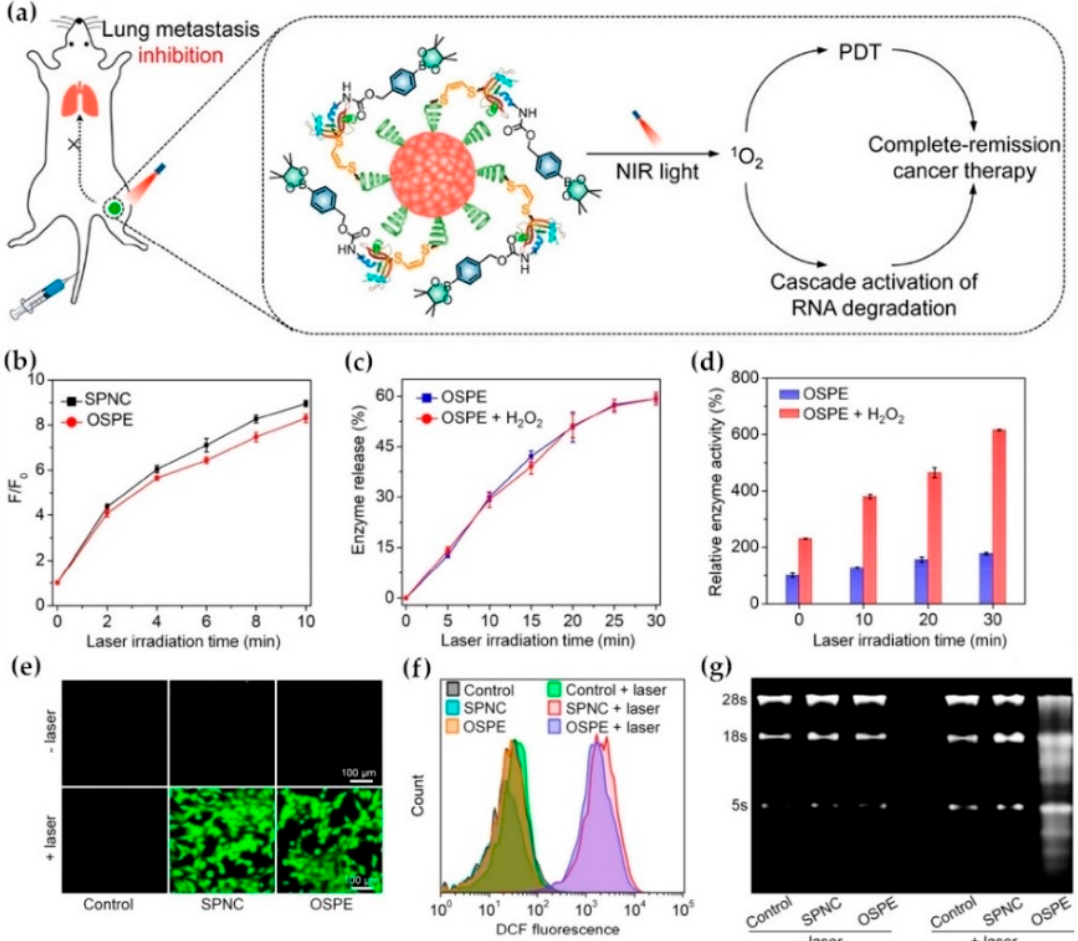
Figure 11. ( a ) Anticancer mechanism of NIR / 1 O 2 dual stimuli-responsive organic semiconductor pro-nanoenzyme (OSPE). ( b ) Under NIR irradiation, 1 O 2 was generated by SPNC (control nanoparticles without enzyme modification) or OSPE. ( c ) The correlation of the amount of enzyme released from OSPE with the time of NIR irradiation. ( d ) In the absence and presence of H 2 O 2 , the relative enzyme activity of OSPE after NIR light irradiation for di ff erent times. ( e ) Confocal fluorescence images and ( f ) flow cytometry analysis of 4T1 cancer cells treated with SPNC or OSPE ([SPN] = 40 µ g / mL) with or without 808 nm laser irradiation (0.3 W / cm 2 ) for 10 min. ( g ) The agarose gel electrophoresis of RNA extracted from 4T1 cancer cells, treated with SPNC or OSPE ([SPN] = 40 µ g / mL), and treated with or without 808 nm laser irradiation (0.3 W / cm 2 ) for 10 min. Reproduced with permission from the publisher of corresponding reference [223].